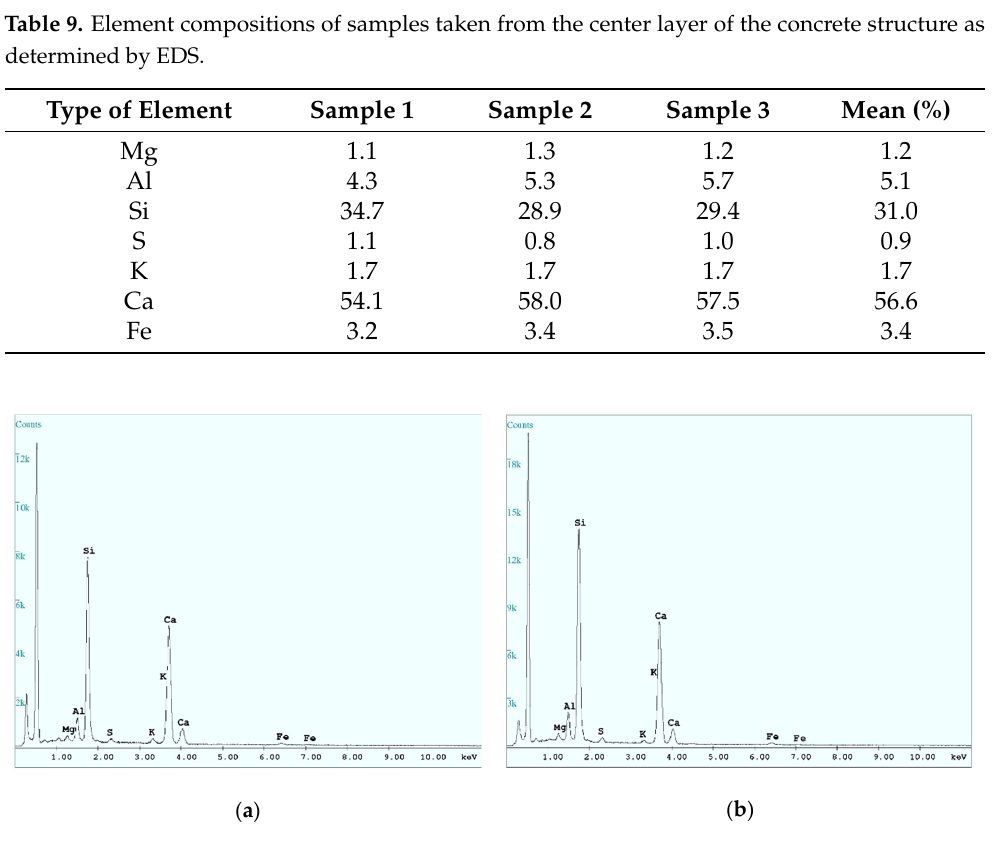
Figure 7. Energy-dispersion X-ray spectrometer (EDS) spectra of samples taken from the ( a ) cover layer; ( b ) center layer. Table 8. Element compositions of samples taken from the cover layer of the concrete structure as